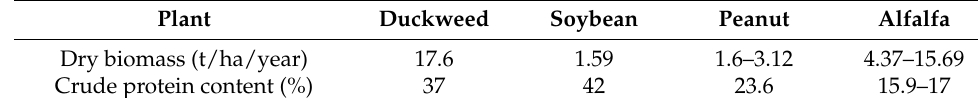
Table 3. Comparison of protein yield between duckweed and high-protein crops [51].